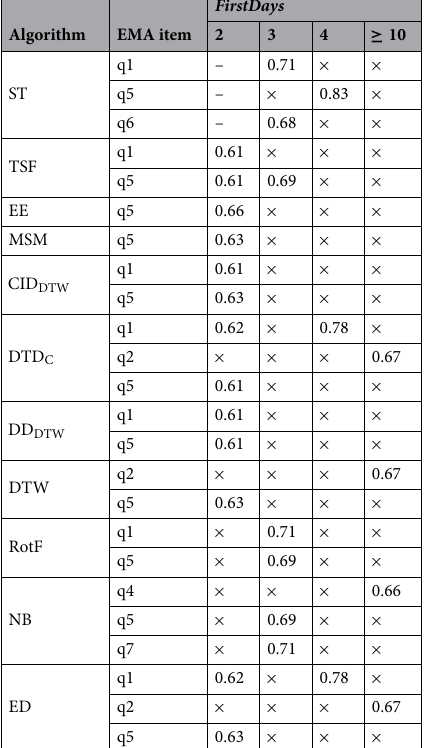
Table 3. Models with an improvement of at least τ improve percentage units over accuracy ( Return = Yes/No ) in dependence of FirstDays value (columns) and EMA item (row), for a horizon of observations of 30 days and a cut-off τ early = 9 days.